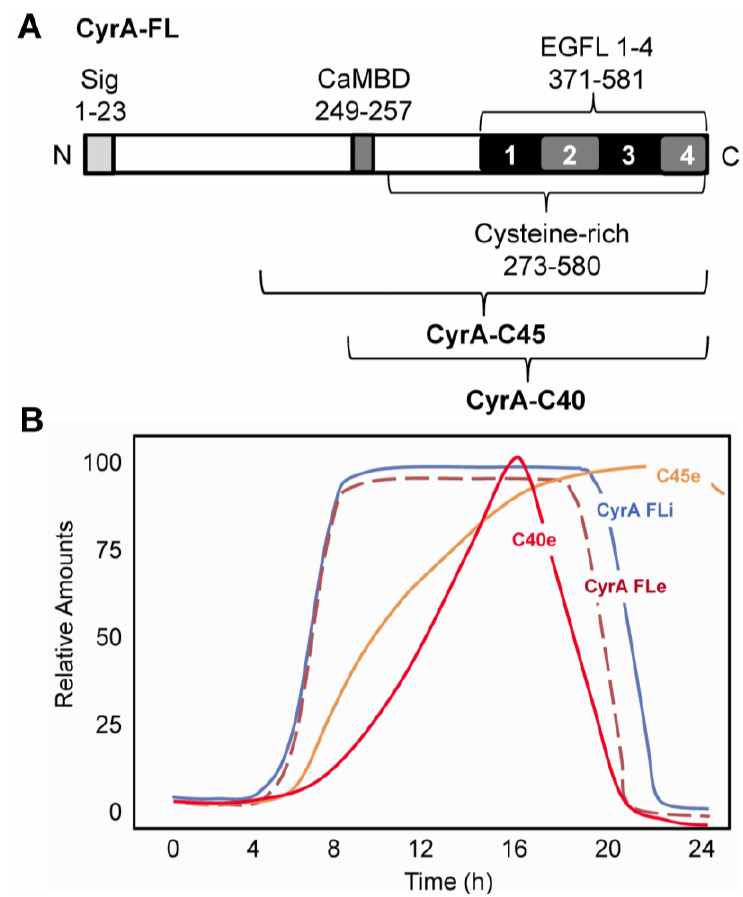
Figure 1. The structure and processing of CyrA. A. CyrA possesses an N-terminal signal sequence (Sig), a calmodulin-binding domain (CaMBD) and four tandem EGF-like repeats (EGFL1-4) in its cysteine-rich C-terminal region. The presumptive C-terminal CyrA-C45 and CyrA-C40 proteolytic products are shown. B. Time course of accumulation of full-length intracellular (CyrA FLi) and extracellular (CyrA FLe) CyrA and